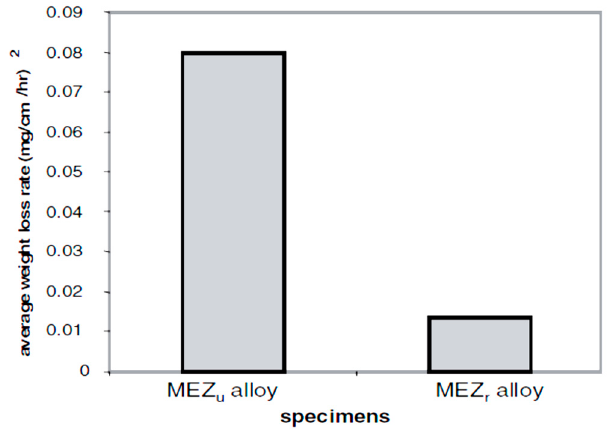
Figure 27. Weight loss rate for MEZ u and MEZ r specimens. Modified from [151].